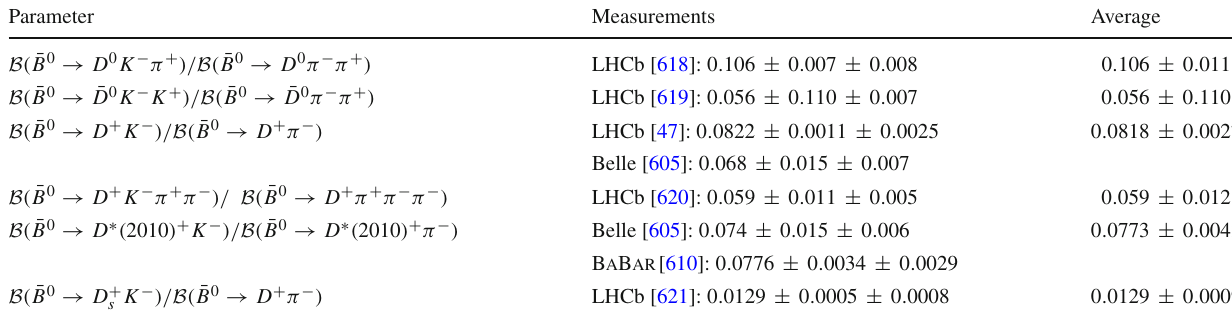
Table 100 Relative decay rates II